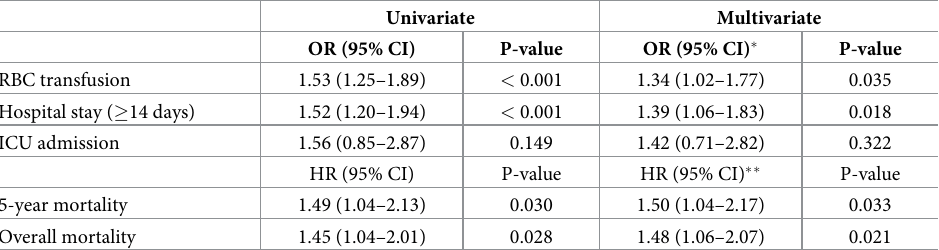
Overall mortality � Adjusted for hemoglobin, BMI, FIGO stage, operation time, total fluids, synthetic colloid use, and laparoscopic surgery �� Adjusted for BMI, FIGO stage, and histology OR: odds ratio; HR: hazards ratio; CI: confidence interval; RDW: red cell distribution width; RBC: red blood cells; ICU: intensive care unit; BMI: body mass index; ASA: American Society of Anesthesiologists; FIGO: International Federation of Gynecology and Obstetrics Values are expressed as mean ± standard deviation, median (interquartile range), or n